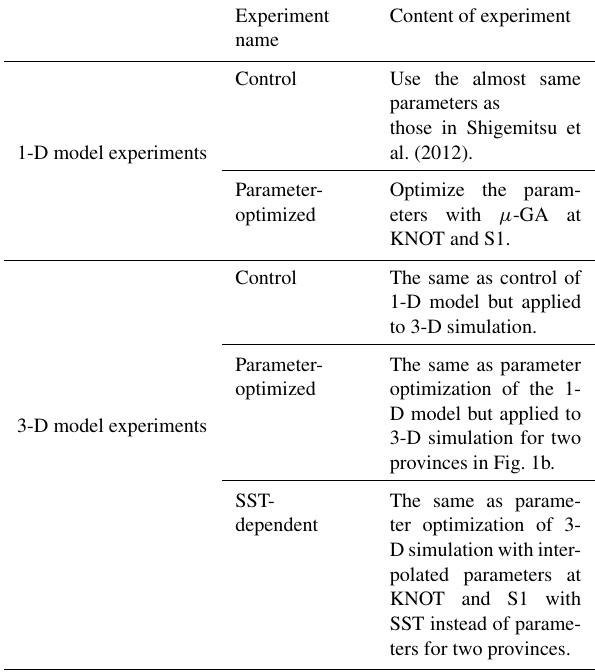
Table 1. List of